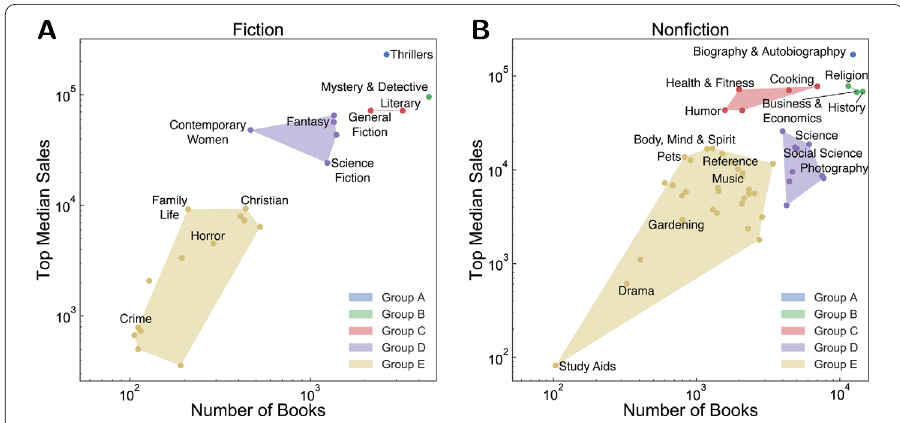
Figure 1 Clustering of genres under ( A ) fiction and ( B ) nonfiction. The results are generated with K-means algorithm with number of clusters k = 5 for both fiction and nonfiction. The algorithm is based on the number of books and the top median sales for each genre, where the top median sales is the median sales of the top 100 most-selling books under this